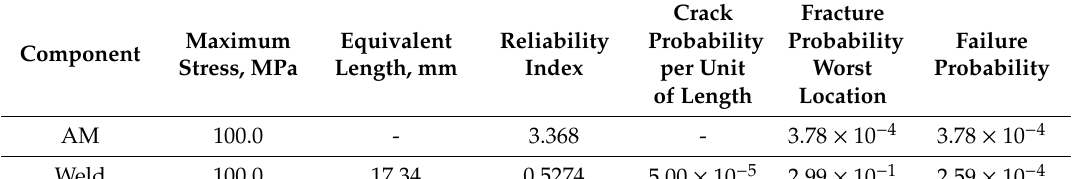
Table 3. Am-case fracture probability at the end of the service life (300 load cycles).